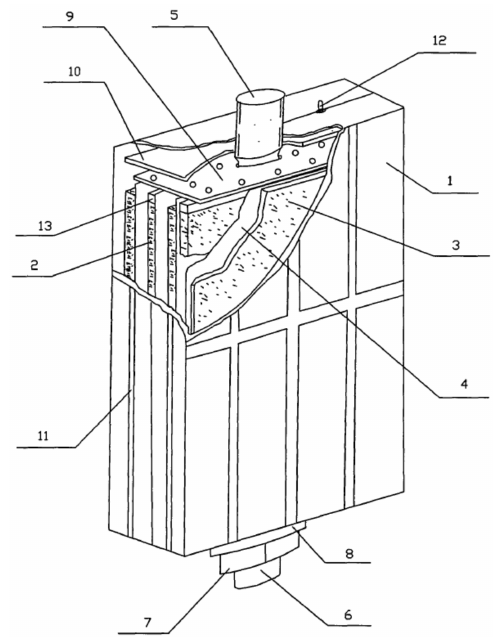
Figure 17. Schematic diagram of a bipolar/prismatic cell with 1: resin case, 2: positive electrode, 3: negative electrode, 4: separator, 5: positive terminal, 6: negative terminal, 7: screw, 8: washer, 9: positive current collector, 10: sealing plate, 11: liquid conduit slot, 12: safety venting valve, and 13: bare substrate [209].